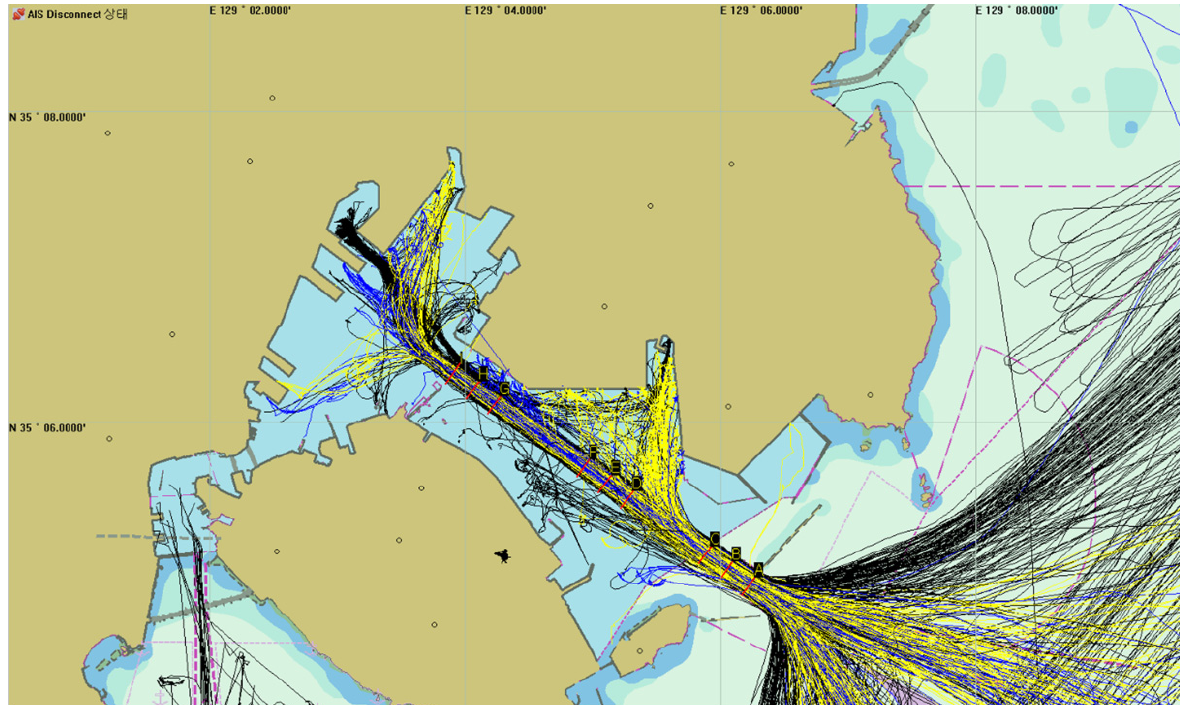
Figure 8. Accumulated navigation trajectories in Busan North Port.